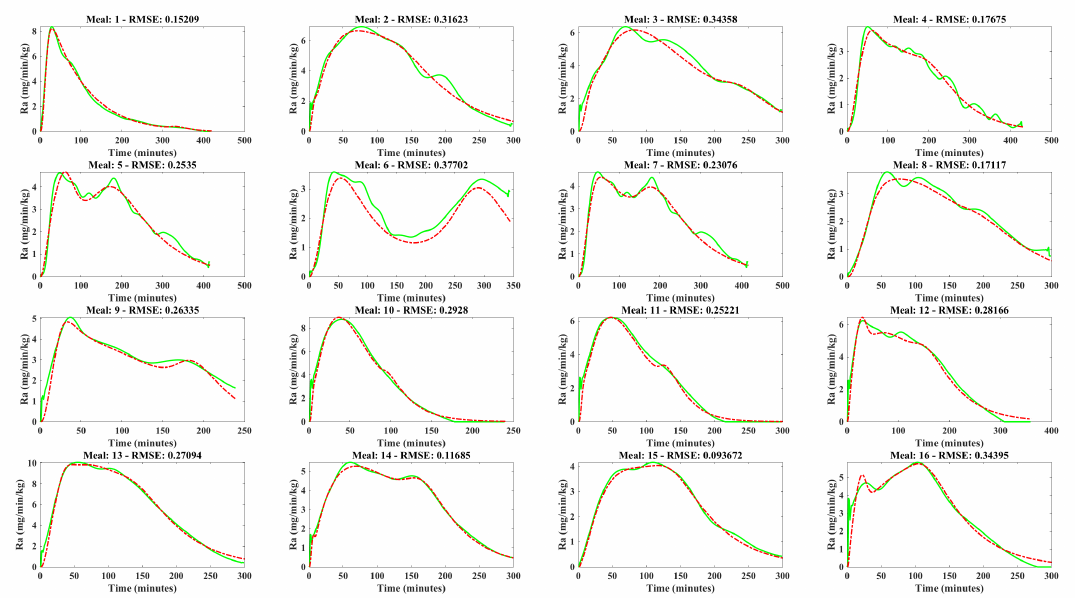
Figure A1. Gastrointestinal model fitting of the 16 estimated R a profiles. Green solid line represents the reference R a and the red dashed line the model